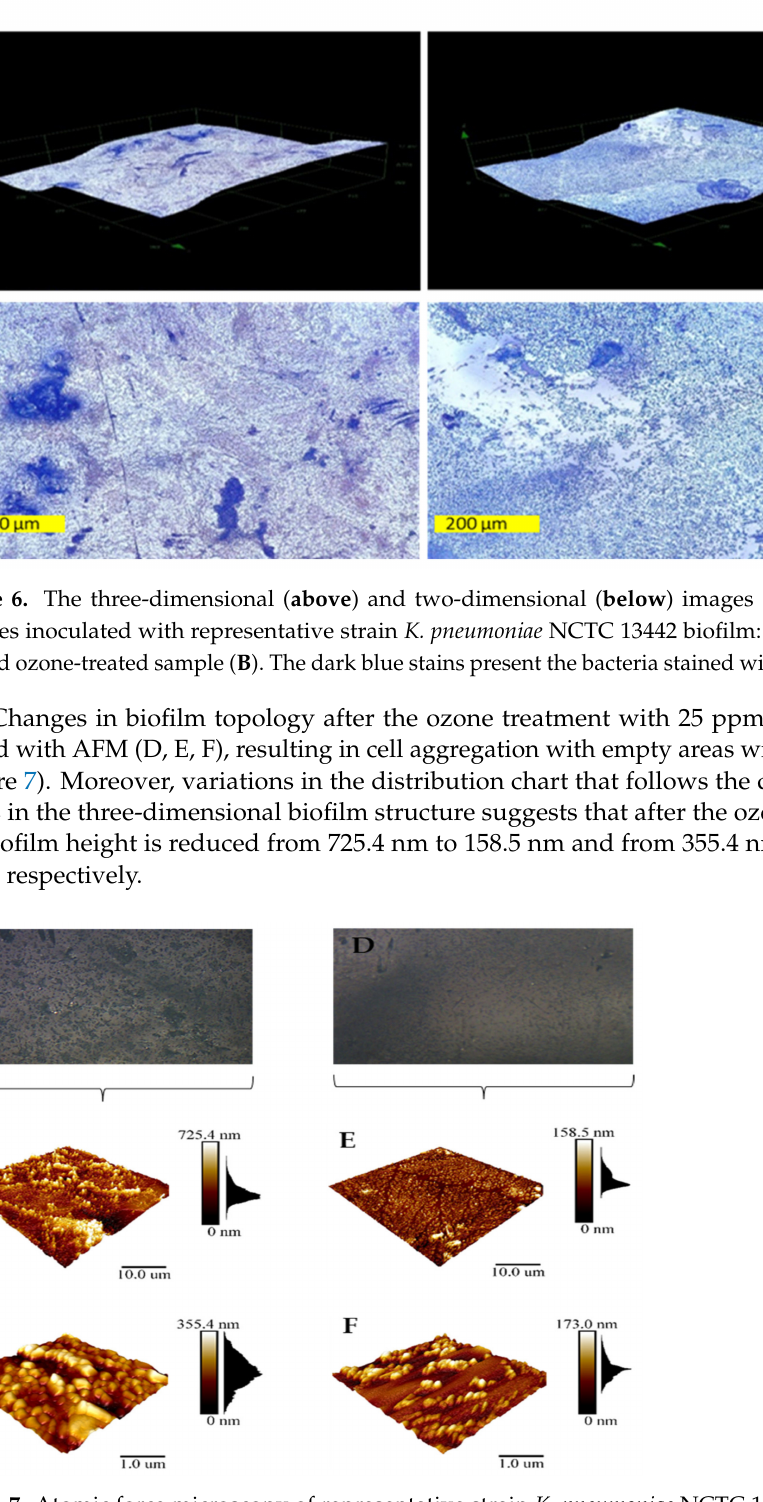
Figure 7. Atomic force microscopy of representative strain K. pneumoniae NCTC 13442 biofilm on ceramic tiles. Topology of biofilm created after 24 h ( A – C ) and topology of biofilm treated with 25 ppm of ozone for 1 h ( D – F ). Scanning area for ( B , E ) is 10 µ m × 10 µ m and for ( C , F ) is 1 µ m × 1 µ